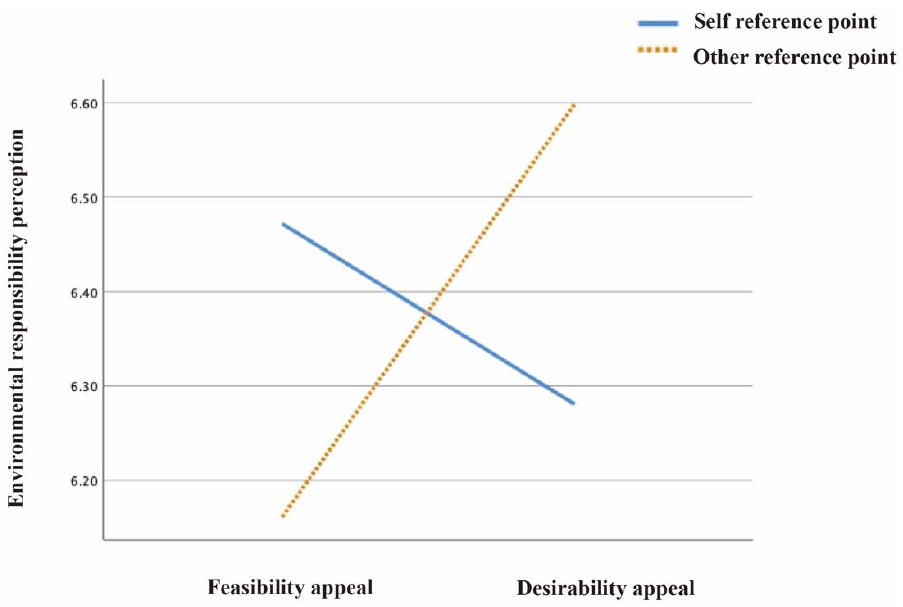
Figure 3. The effect of text appeals on environmental responsibility perception, assessed by image reference point.